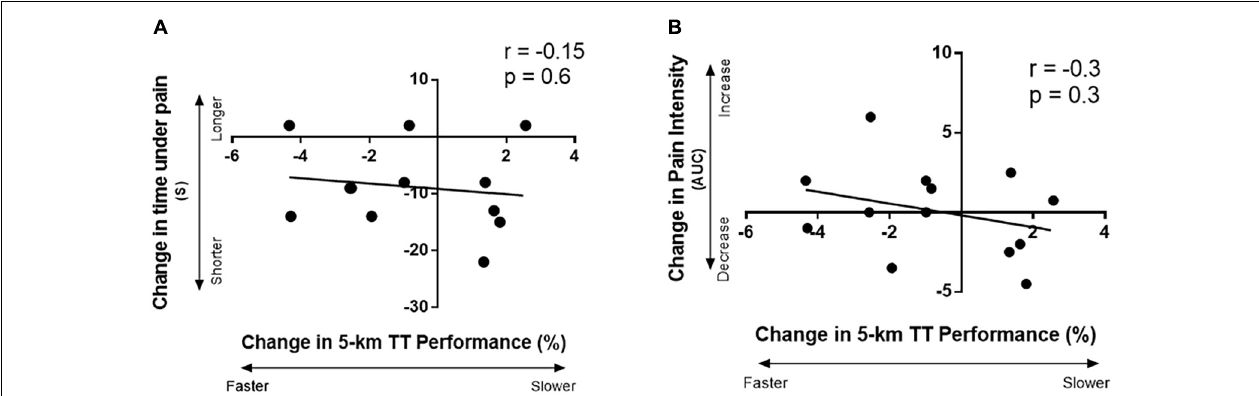
FIGURE 5 | Correlation between the change in 5-km TT performance with IPC with: (A) the change in time under pain (s) after IPC (time under pain represented total time from when the participant first reported pain after introduction of the cold stimulus to when the pain was completely gone after removal of the cold stimulus), and (B) the change in pain intensity area under the curve with IPC; area under the curve was calculated from the reported pain intensity Likert scores from a cold-water immersion test.